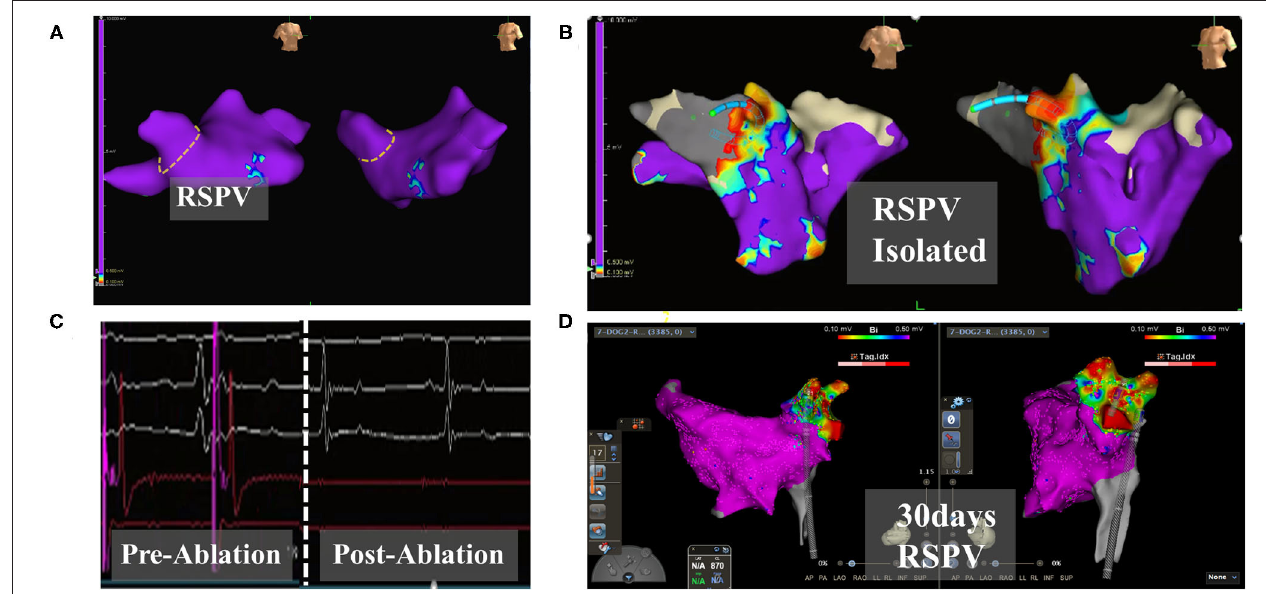
FIGURE 2 | Electroanatomic modeling of the right superior pulmonary vein. (A) Baseline potentials in right superior pulmonary were assessed. The yellow dotted line draws the right superior pulmonary vein ostia. (B) Post-operative ablation site shows a low potential area. (C) Pulmonary vein electrograms from PFA catheter ablation. Left: Pre-ablation. Right: Post-ablation. (D) Right superior pulmonary vein potential after 30 days. Continuous low potential in the ablation zone. The color of the mapping from red to purple indicates the potential from low to high. EnSite, Abbott: (A–C) . Carto3, Johnson & Johnson: (D) .